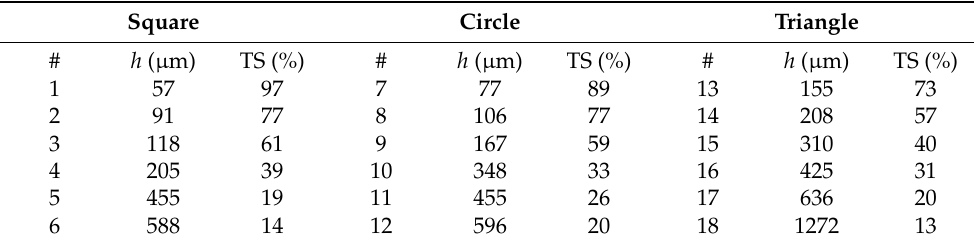
Table 2. List of the fs-laser textured samples grouped based on the texture geometry. For each sample, the pitch distance ( h ) and the percentage of textured surface (TS) are reported.